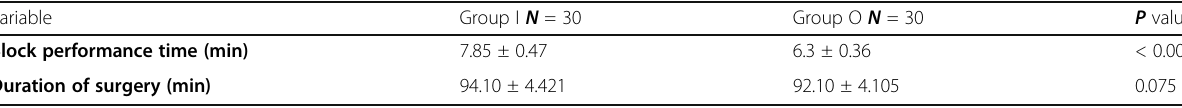
Table 2 The block performance and operative